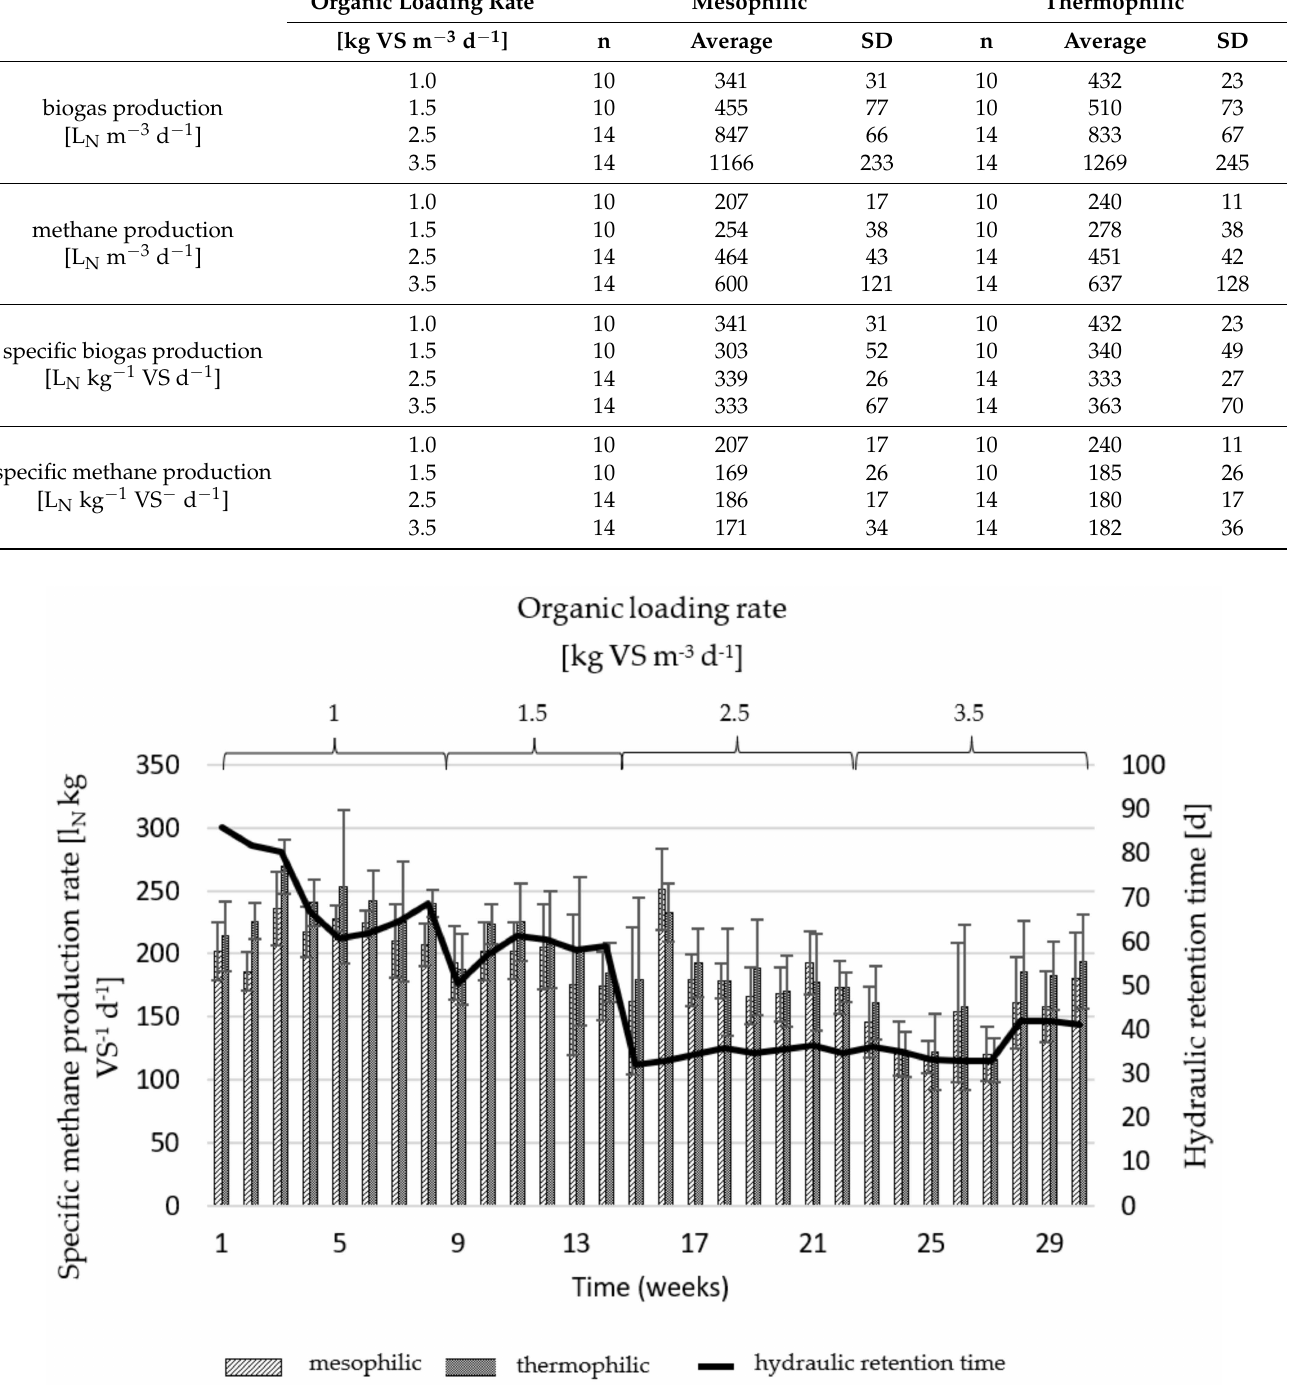
Figure 2. Weekly variations in the specific yield of the reactors for methane production over the operating